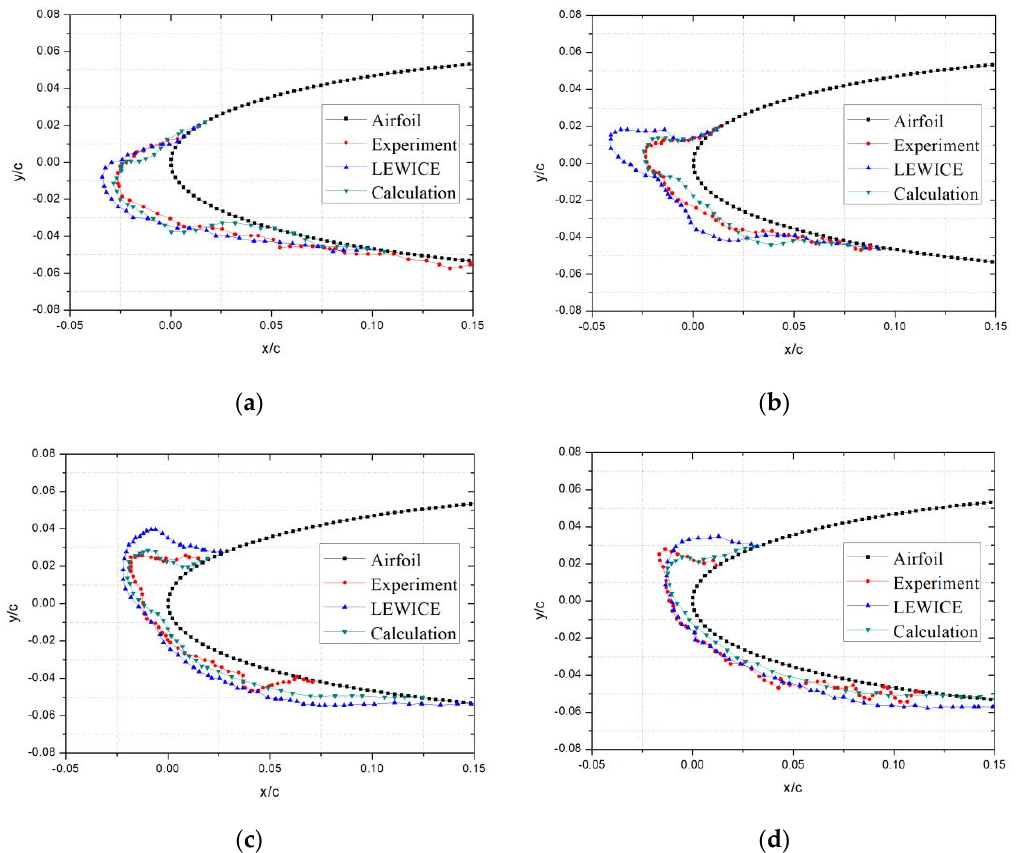
Figure 2. Comparison of ice shapes under different conditions: ( a ) Case 1; ( b ) Case 2; ( c ) Case 3; ( d ) Case 4.